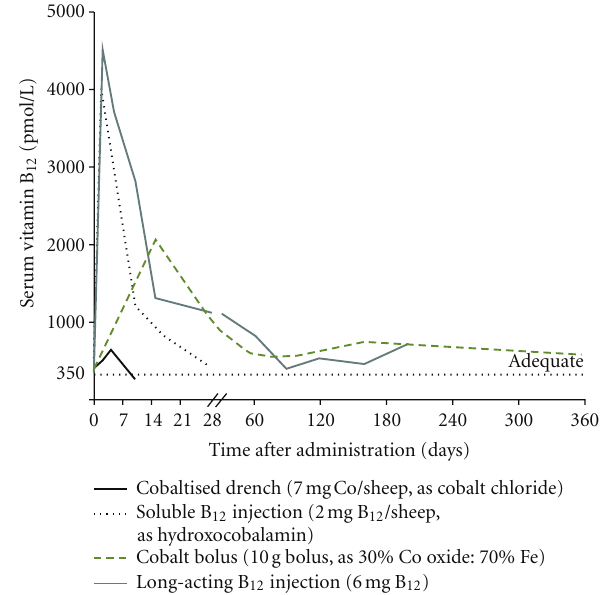
Figure 2: Comparison of the e ff ects of administration of a cobaltised oral drench, a soluble vitamin B 12 injection, a Co- containing intraruminal bolus, and a long-acting vitamin B 12 injection on the serum vitamin B 12 concentrations of sheep. Serum vitamin B 12 > 350pmol/L indicates adequate vitamin B 12 status, above which animals are unlikely to respond to supplementation in terms of improved performance or